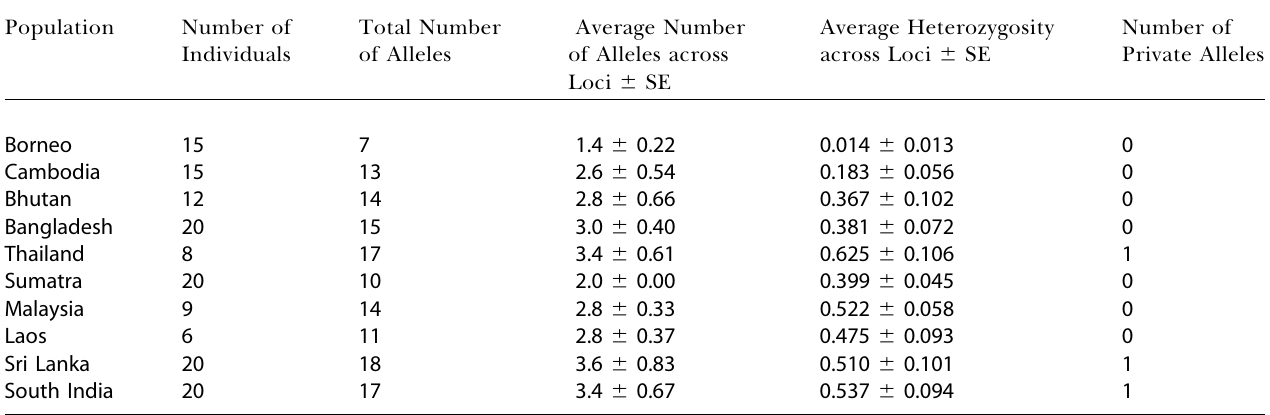
Table 2. Measures of Genetic Variation Using Five Loci, in Asian Elephant Populations from across the Range Population